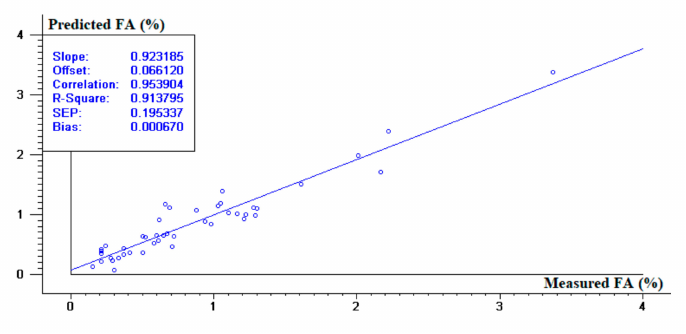
Figure 3. Performance of the 800–2200 partial least squares (PLS) model for free acidity (FA) determination.